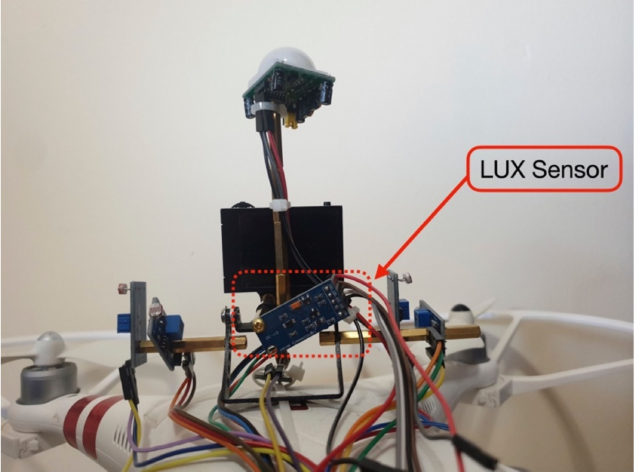
Figure 12. The sensor (Lux) was moved to the backside of the drone to detect the light from the controlled